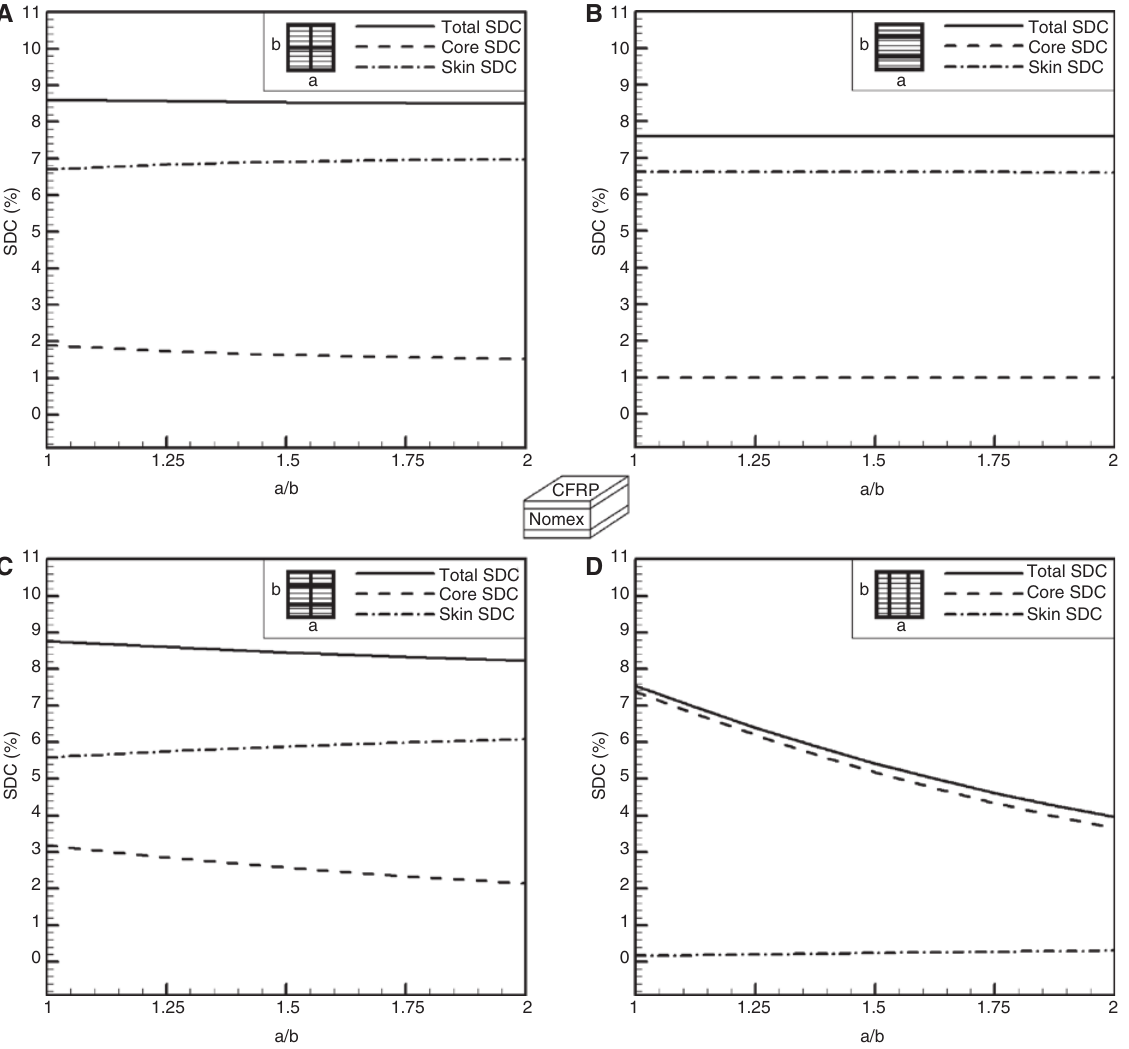
Figure 2: Damping of an all-free, all-zero CFRP/Nomex honeycomb sandwich panel versus aspect ratio in various modes. (A) First mode, (B) second mode, (C) third mode, (D) fourth